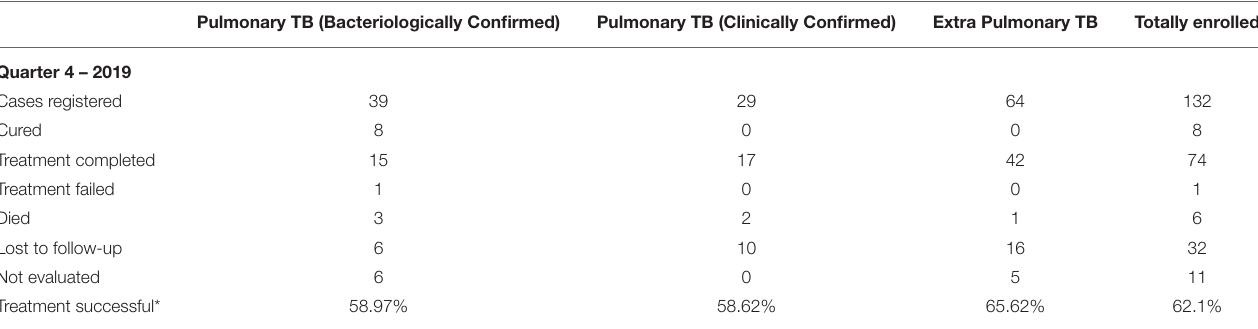
TABLE 5 | Tuberculosis treatment outcomes in cohort of patients who started treatment regimen the in fourth quarter of